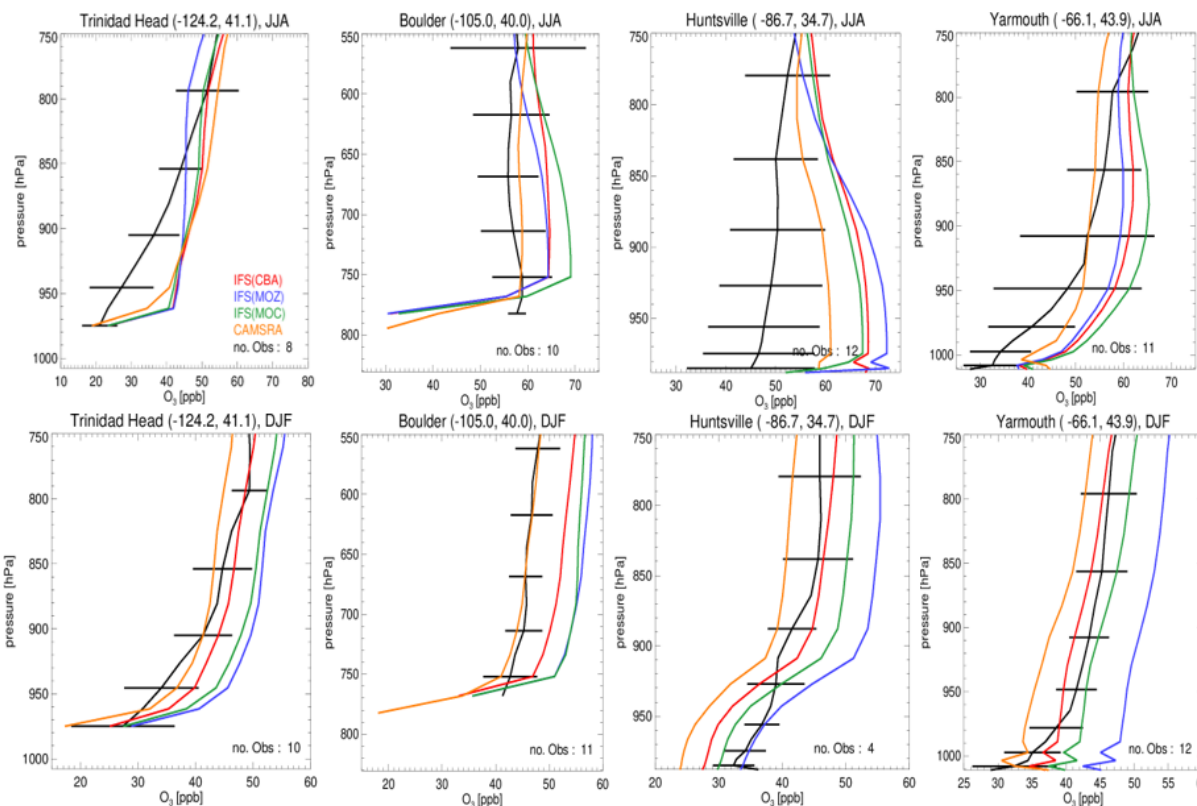
Figure 3. Seasonal O 3 sonde comparisons for seasons JJA (top) and DJF (bottom) for the lower troposphere. Stations shown are Trinidad Head, Boulder, Huntsville and Yarmouth, which are situated across the US and Canada. The observational composites are shown in black, with the color key provided in the top-left panel. The geolocation of each site is given in the title of each panel, and the number of observations used is given at the bottom right of each panel. Please note that the scales on the x and y axes vary with respect to station.